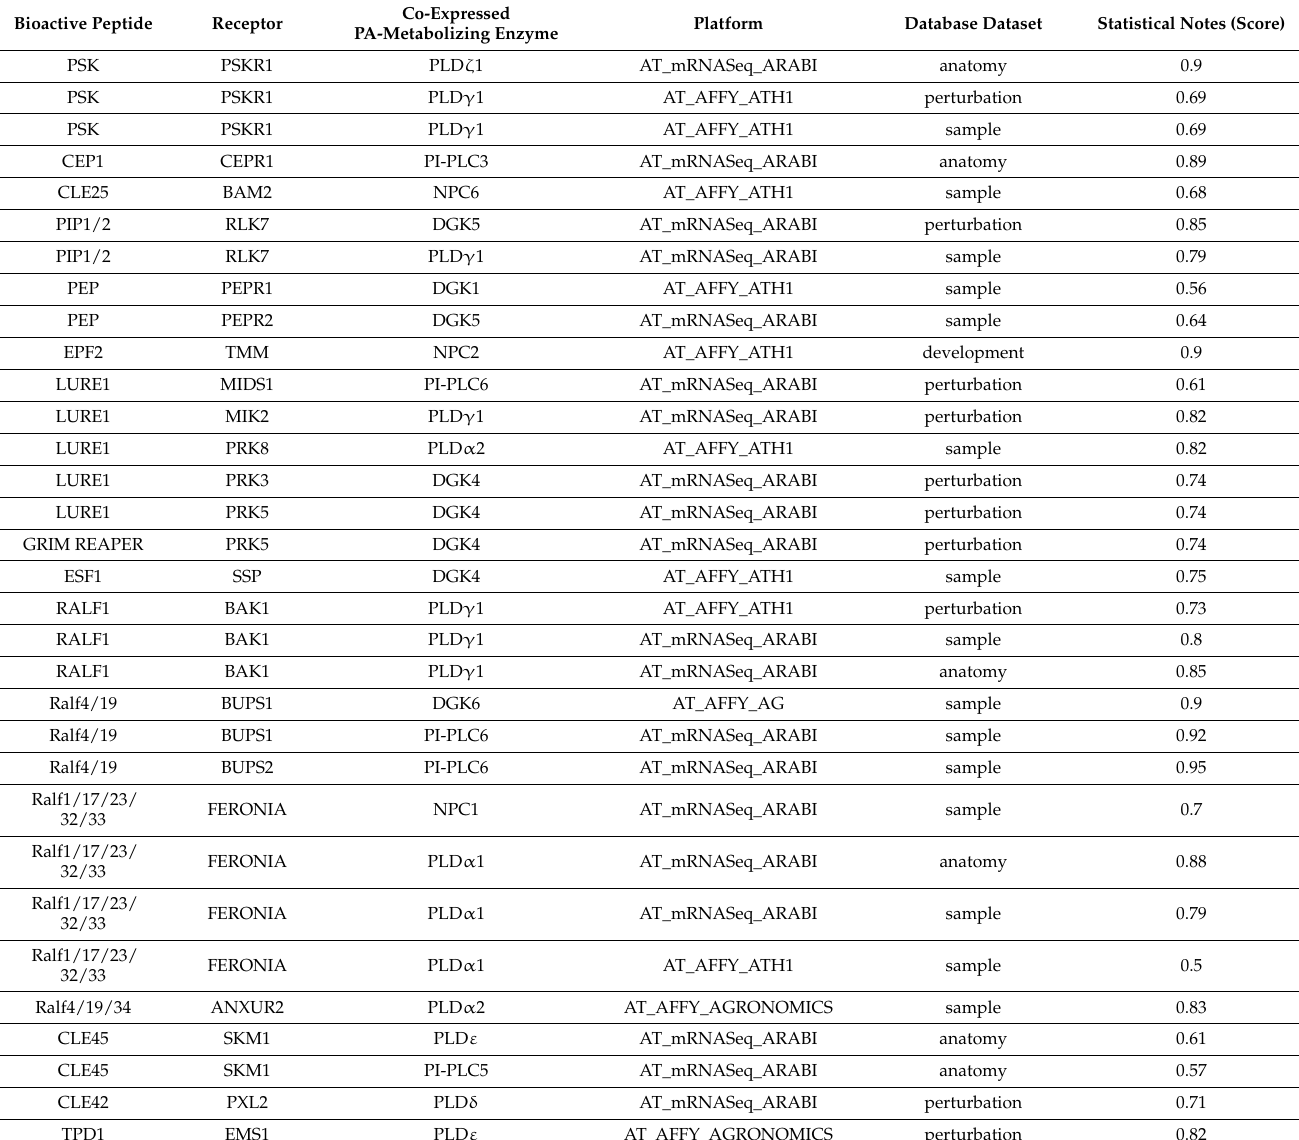
Table 2. Co-expression analysis of Arabidopsis thaliana genes coding selected peptide receptors and enzymes of PA signaling performed in silico using “Genevestigator” database [55]. All statistical data were implemented and provided by “Genevestigator” database; 1031 samples, 25 anatomical parts, 691 perturbations (AT_mRNASeq_ARABI), 10615 samples, 3243 perturbations, 7 developmental stages (AT_AFFY_ATH1) were analyzed. Pearson’s correlation coefficient (score) was used for statistical analysis of gene co-expression. Database dataset denotes aggregated expression data according to a specific category (samples, anatomy, development,